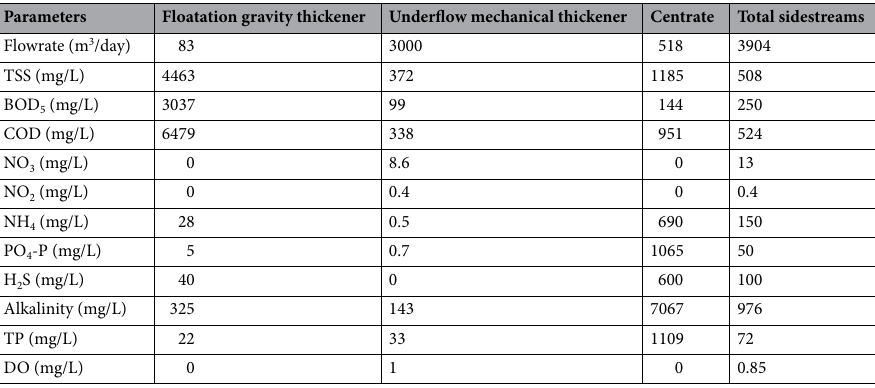
Table 3. Physiochemical characteristics of sidestreams in Karbala